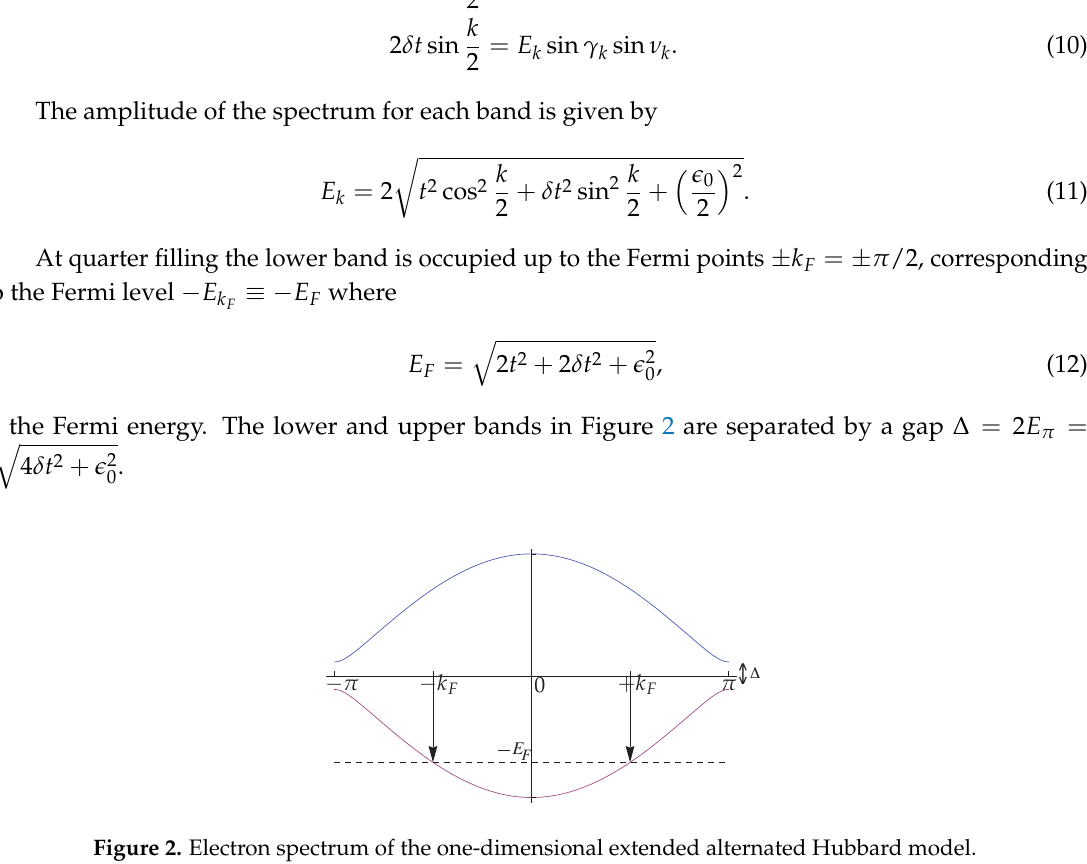
Figure 2. Electron spectrum of the one-dimensional extended alternated Hubbard